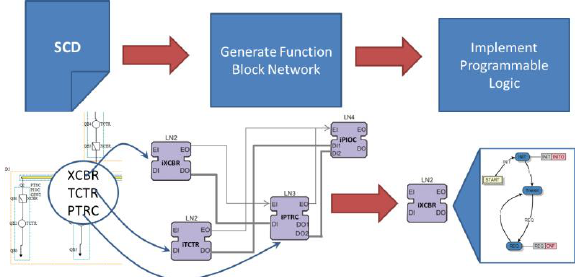
Figure 8. Automatic generation module of SysGRID.